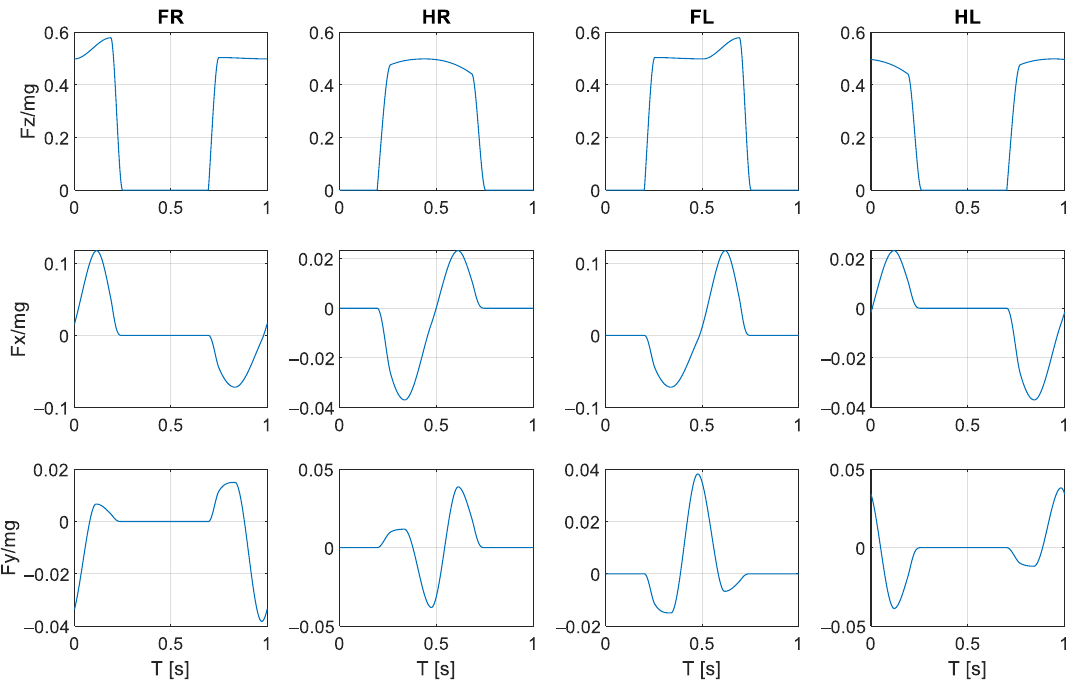
Figure 11. Contact forces normalized over the body weight.